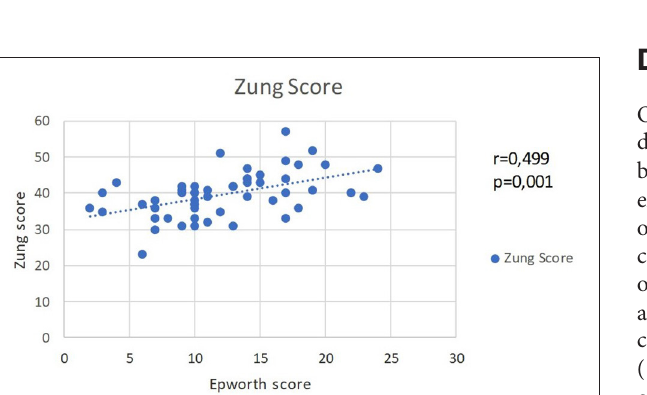
FIGURE 2 | Moderate straight correlation between OSA severity and the scores from TMT, part B.